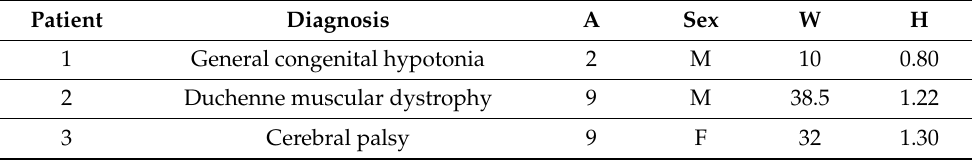
Table 2. Characteristics of the patients of this